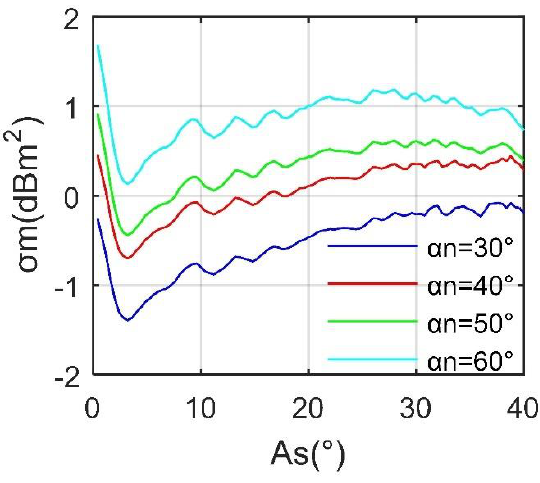
Figure 11. Average RCS of the aircraft obtained by FAM, where α m = 90°, β = 0°, and F rv = 5 GHz.